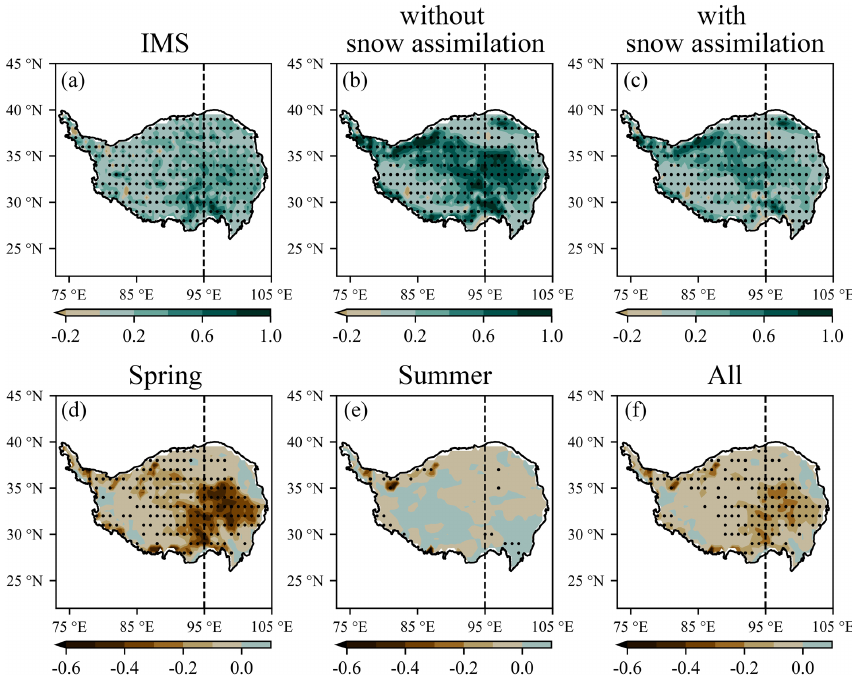
Figure 2. (a–c) The spatial differences in snow cover fraction between IMS and TPSCF and between the ensemble reforecasts and TPSCF in spring. (d–f) The spatial differences in snow cover fraction between the two reforecasts (the DA reforecasts minus the control reforecasts). The stippled regions show the statistical significance of the differences identified by the t test at a 5% significance level.